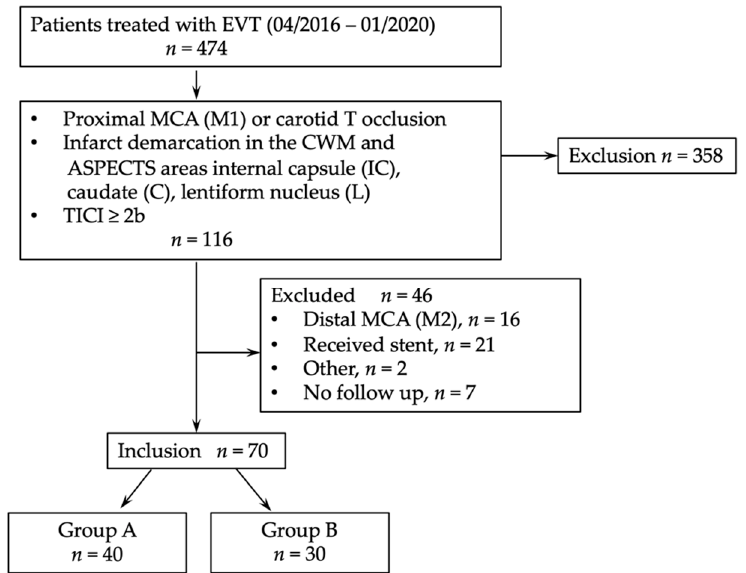
Figure 1. Consort diagram. EVT, endovascular thrombectomy; MCA, middle cerebral artery; TICI, thrombolysis in cerebral infarction.